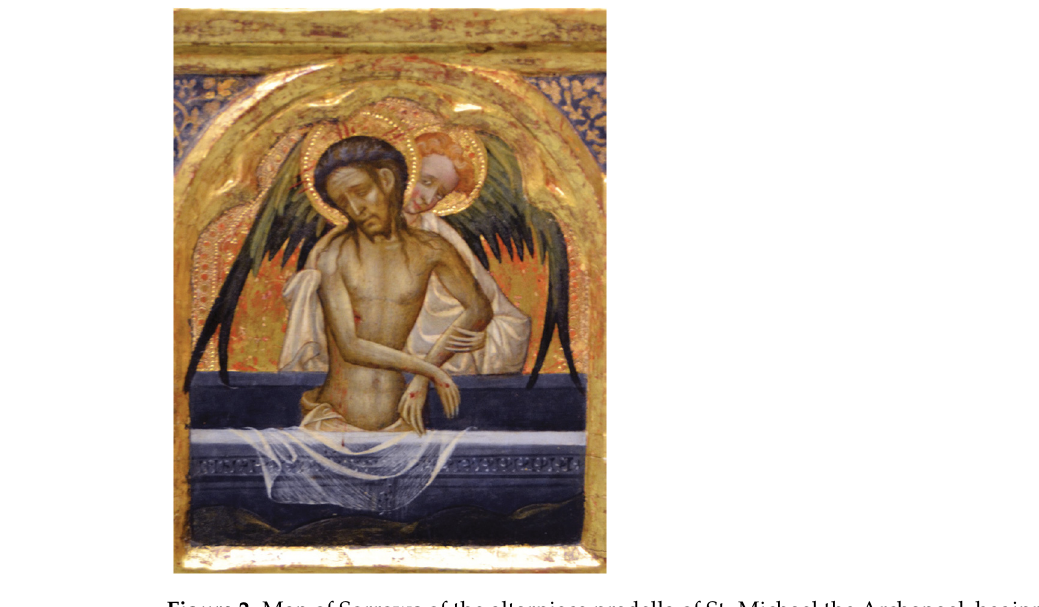
Figure 2. Man of Sorrows of the altarpiece predella of St. Michael the Archangel, beginnings of the 15th century, Museu de Belles Arts of Valencia. © Museu de Belles Arts of Valencia.